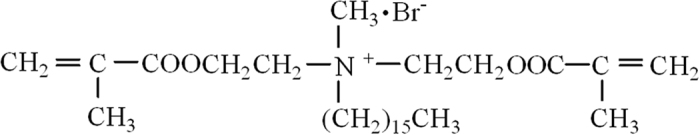
Structure of the QAS monomer, MAE-HB.